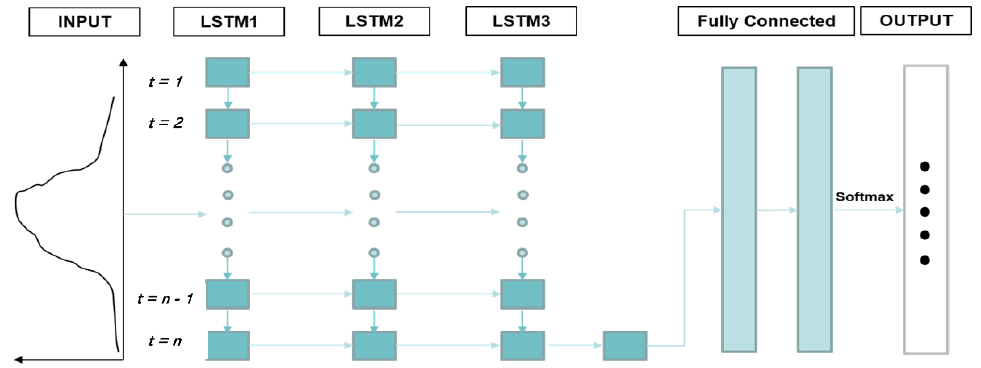
Figure 4. Schematic diagram of the long short-term memory (LSTM) used in this study. The black dots in the output layer indicate classification probabilities of each crop.